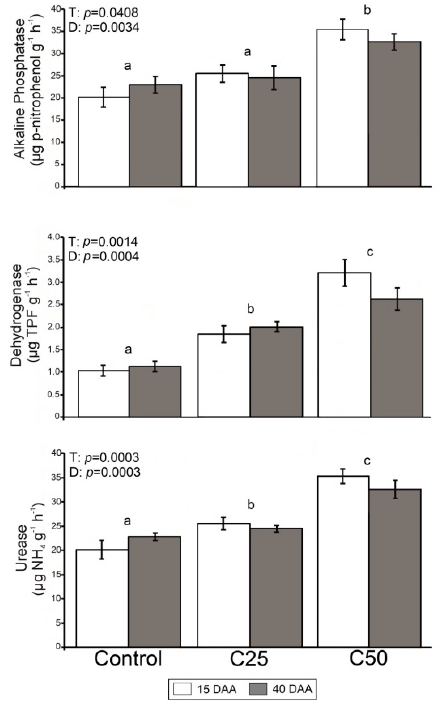
Figure 1. Mean values (± st. error) of variables for microbial groups and results of PERMANOVA regarding the effects of “treatment” (T) and “duration of treatment” (D) on these parameters. Different letters (a, b, c) indicate significant differences of pairwise comparisons among treatments (Control, C 25 and C 50 ).